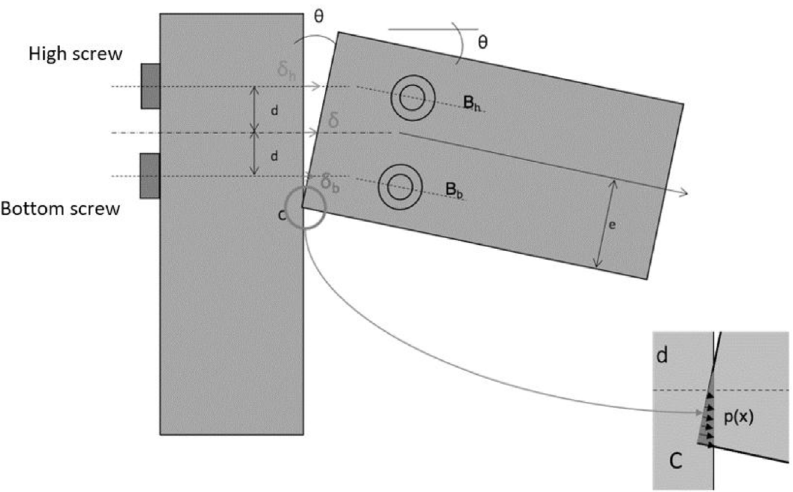
Fig. 13. Two-screws assembly model for the through-bolt connection between two wooden parts of the high loft